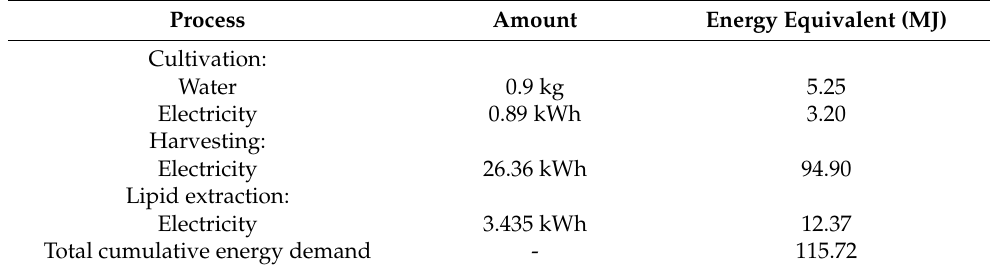
Table 7. The NER values of different microalgal strains in various cultivation